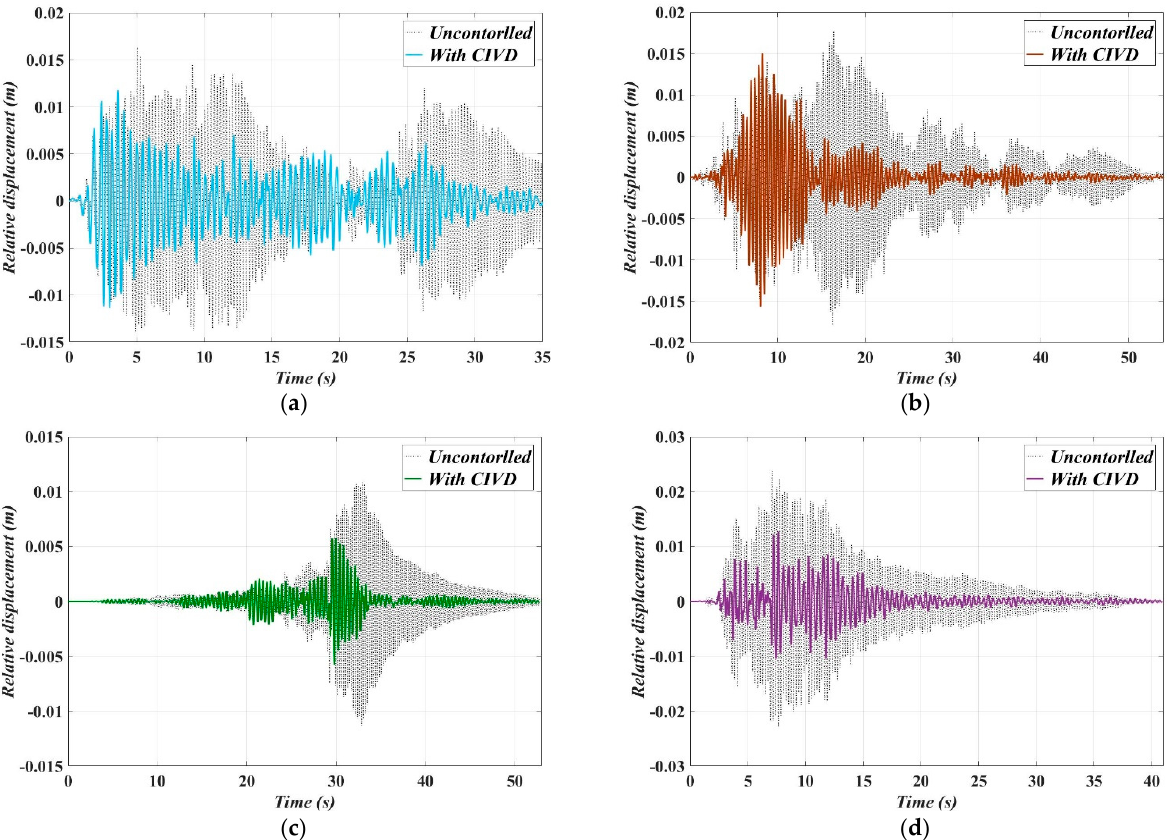
Figure 19. Relative displacement responses of SC eave-grotto system ( γ Ur = 0.6): ( a ) EL Centro; ( b ) Taft; ( c ) Chi-Chi; and ( d ) Kobe.